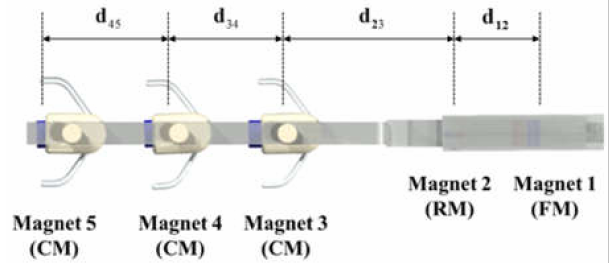
Figure 6. Distances between the magnets in the